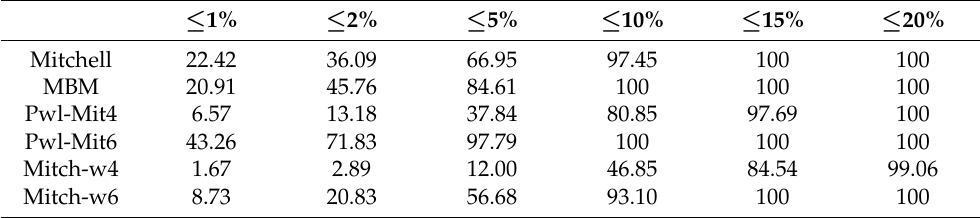
Table 1. Acceptable probability